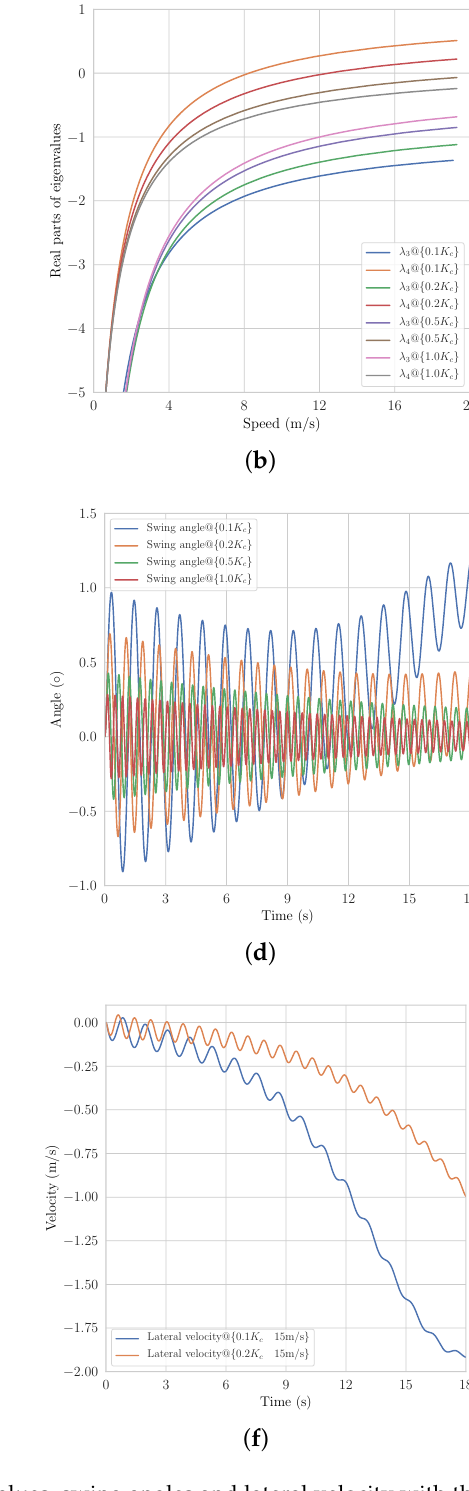
Figure 7. Variation of the real parts of the eigenvalues, swing angles and lateral velocity with the torsional stiffness: ( a ) real parts of λ 1 and λ 2 , ( b ) real parts of λ 3 and λ 4 , ( c ) swing angle of the vehicle at 5 m/s, ( d ) swing angle of the vehicle at 15 m/s, ( e ) swing angle of the vehicle at critical velocity, and ( f ) lateral